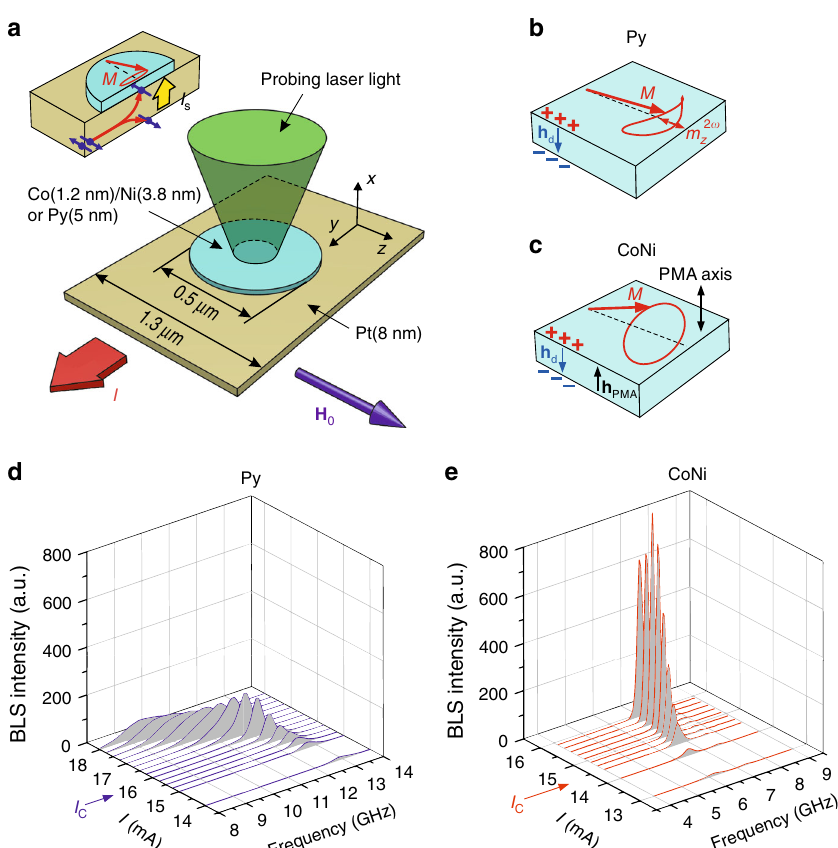
Fig. 1 Schematics of the experiment and spectra of magnetic oscillations. a Layout of the test devices. Magnetic disks are fabricated on top of a Pt strip either from Py, or from the Co/Ni bilayer with PMA tailored to compensate the dipolar anisotropy of the fi lm. Inset illustrates the device operation principle, based on the injection into the ferromagnetic disk of pure spin current generated due to the SHE in Pt. b The ellipticity of the magnetization precession in Py is caused by the dipolar anisotropy. c In CoNi, the ellipticity is minimized due to PMA compensating the dipolar anisotropy. d , e BLS spectra of magnetic oscillations vs current for Py and CoNi disks, respectively. I C marks the critical current, at which the spin current is expected to completely compensate the natural linear magnetic damping. The data were recorded at H 0 = 2.0